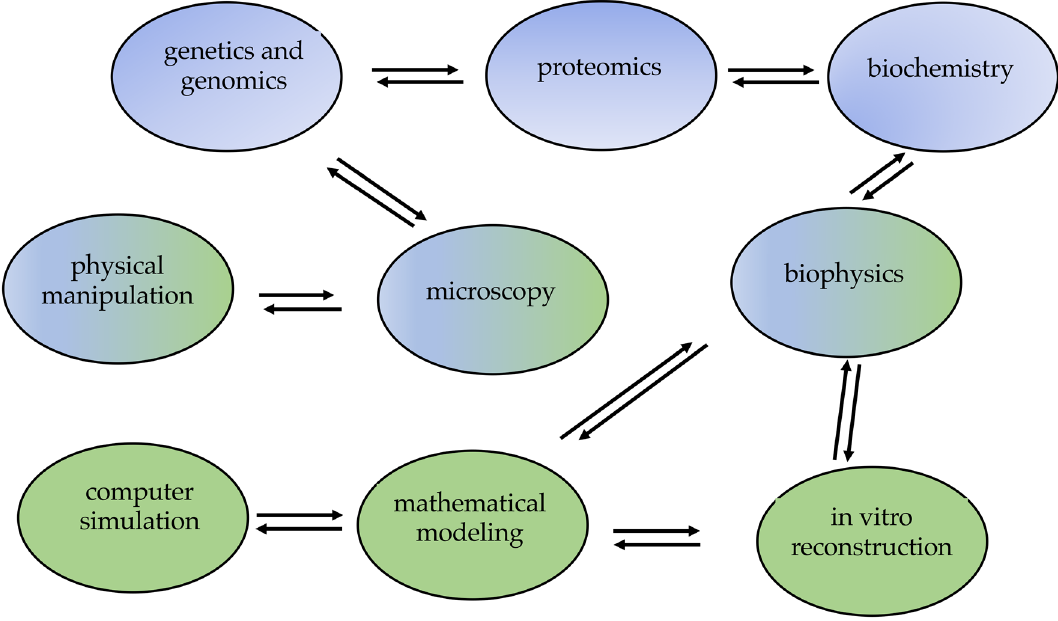
Figure 6. Several complementary methods can be used to identify cytokinesis proteins and to clarify cytokinesis mechanisms.